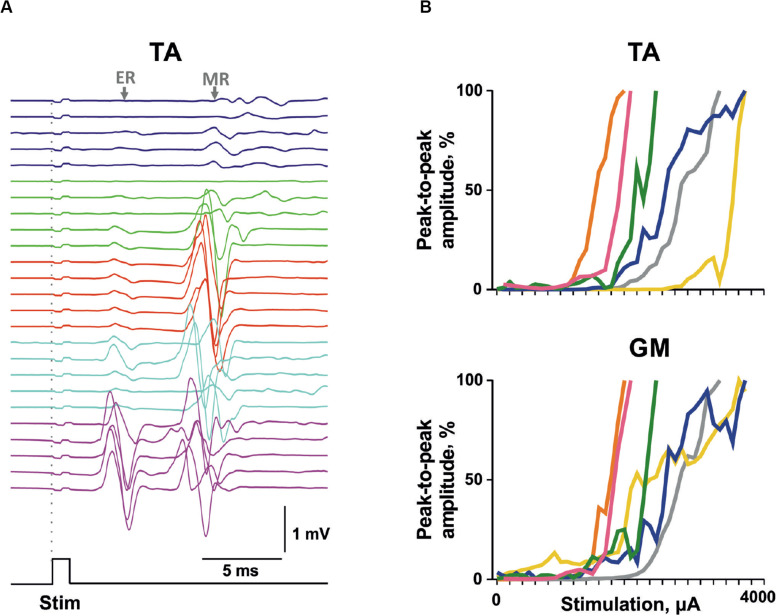
The motor-evoked potentials triggered by transvertebral stimulation in chronic animals. (A) Example of evoked potential recruitment dynamics with increasing current (1,600–2,000 μA) for m. Tibialis anterior (TA). (B) The individual recruitment curves for mm. TA and gastrocnemius medialis (GM) of different chronic rats. Stim, stimulation impulse; ER, early response; MR, medium response.